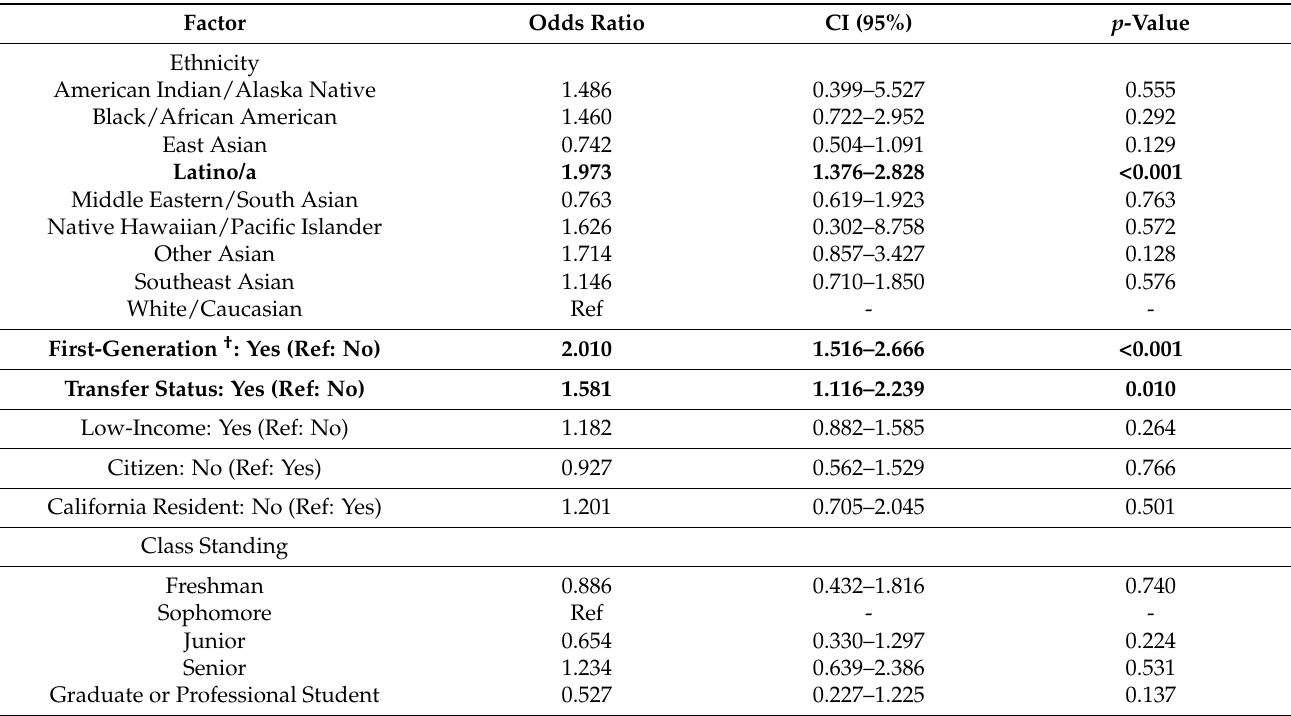
Table 4. Regression Model 1: Logistic Regression of Demographic and Academic Characteristics’ Associations with Food Insecurity ( n =